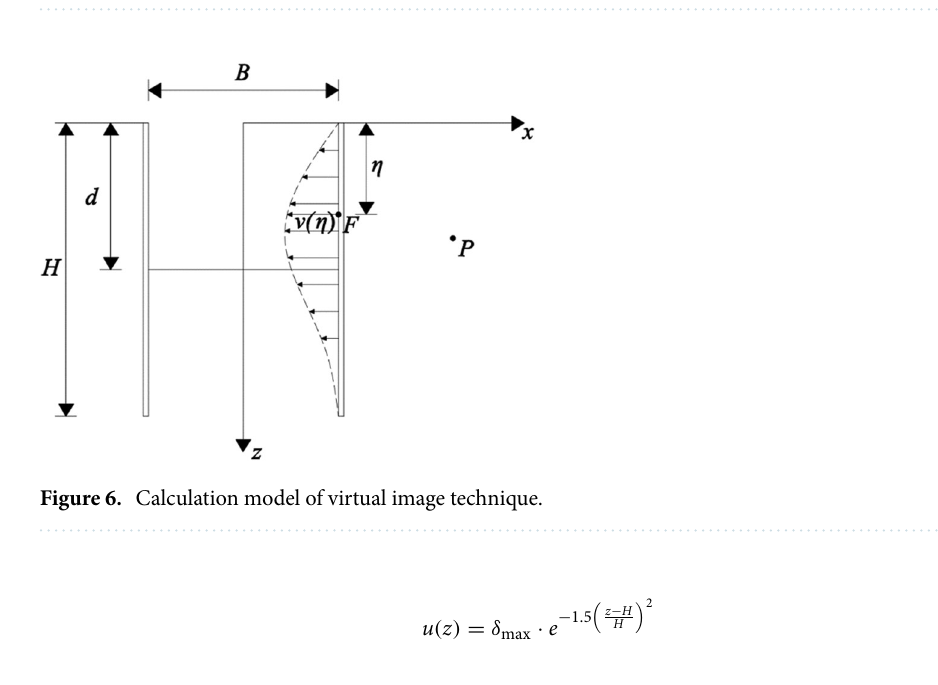
Figure 5. Calculation model of composite deformation.